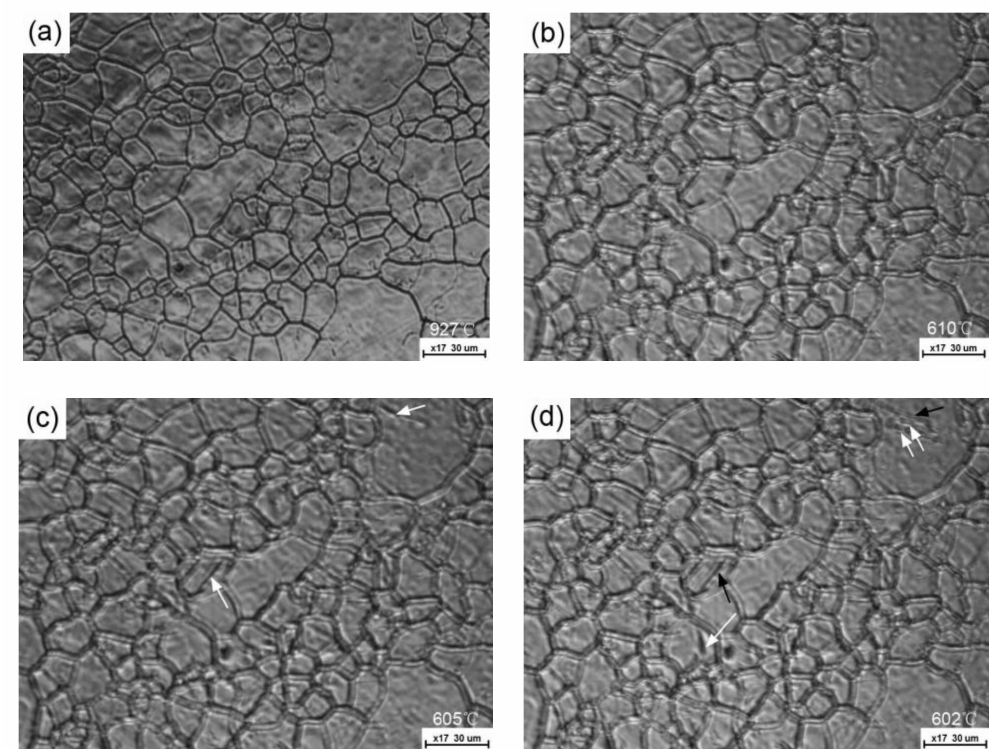
Figure 5. In situ observation of phase transformation with the FGHAZ thermal cycle: ( a ) 927 ◦ C, ( b ) 610 ◦ C, ( c ) 605 ◦ C, and ( d ) 602 ◦ C. (The white arrows show that the ferritic laths form at the moment of real-time photographing for each image, the black arrows show the pre-existing ferritic